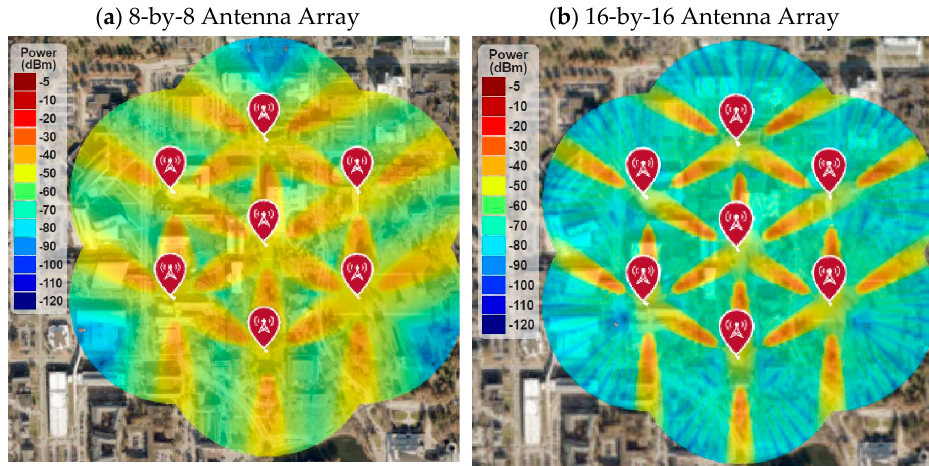
Figure 19. RF coverage and signal strength for 30GHz operating frequency.